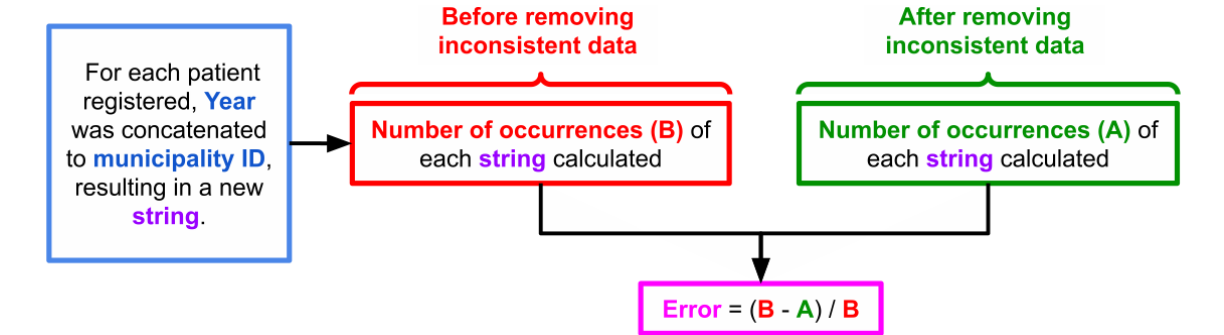
Figure 2. Method to calculate the error